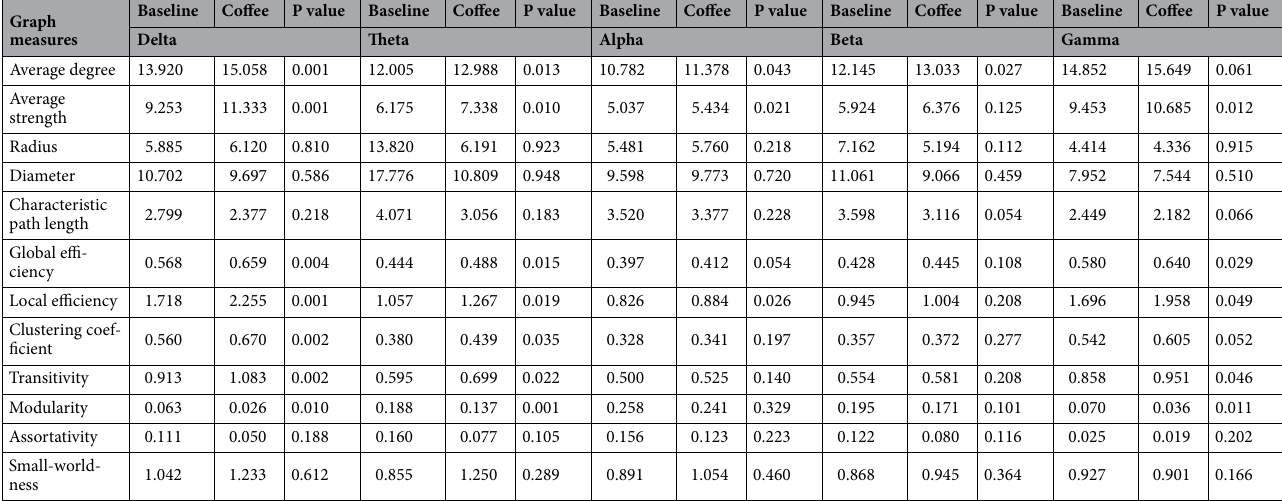
Table 2. Comparisons of global graph measures between baseline and after coffee consumption. Values represent the